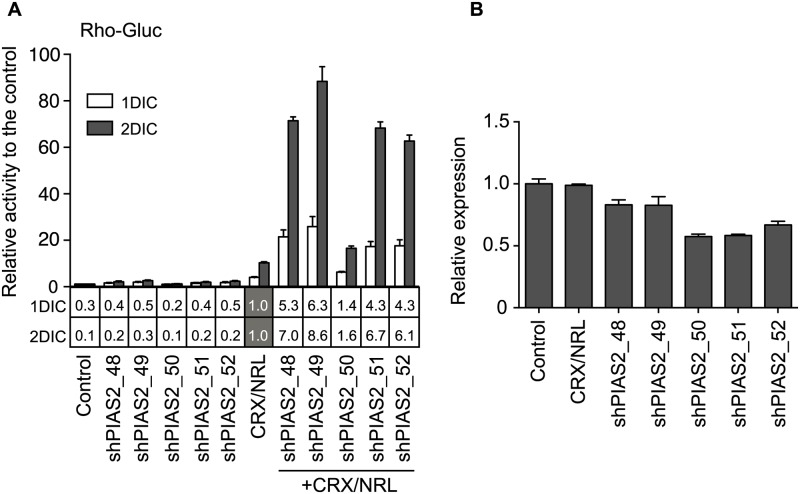
Rho-Gluc activity is synergistically enhanced by shPIAS2 in the presence of CRX and NRL regardless of the knockdown efficiency of endogenous PIAS2.(A) Transient co-transfection assay with rho-Gluc reporter. HEK293 cells were transfected with the reporter and one of five shPIAS2s with or without CRX and NRL expression vectors. Culture medium was collected one and two days after the transfection to measure Gaussia luciferase activity. Relative luciferase activity to the control (bar graph) and the CRX/NRL transfected sample (in the column under the bar graph) are presented. (B) Relative expression level of endogenous PIAS2 mRNA. The expression level was examined by qPCR and normalized by that of GAPDH. Error bars are shown as +/- SE.